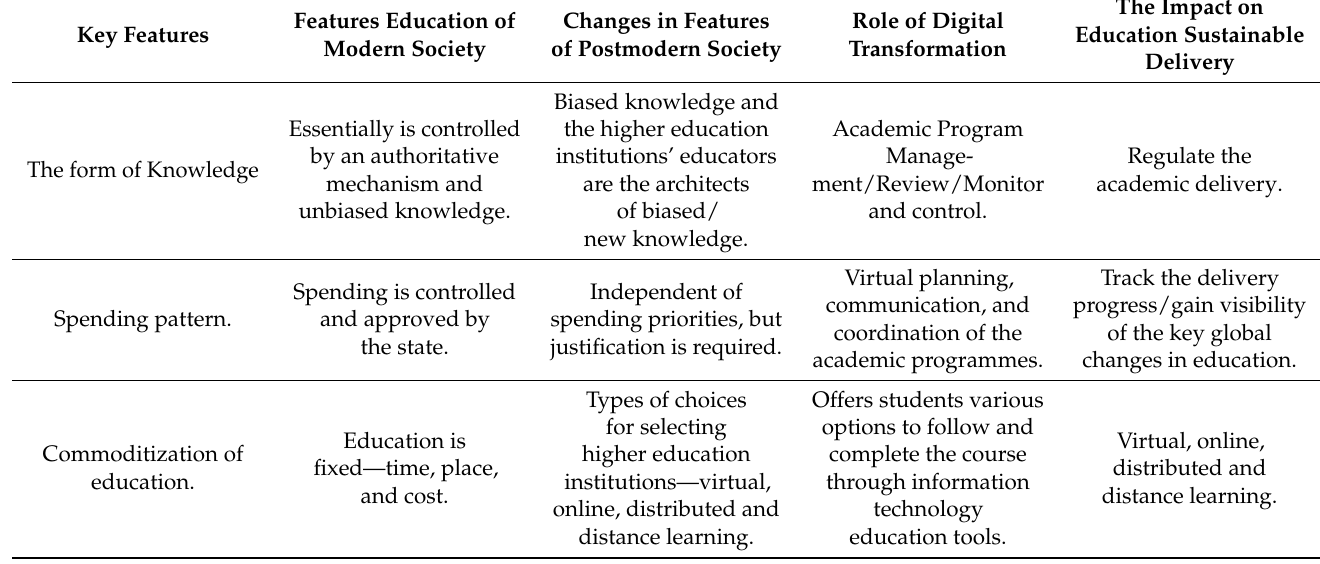
Table 1. Key features of postmodern society and digital transformation. Source: Based on dwellcc.org (2020), Richardson and Jencks (1989), Kahraman (2015), Lyotard